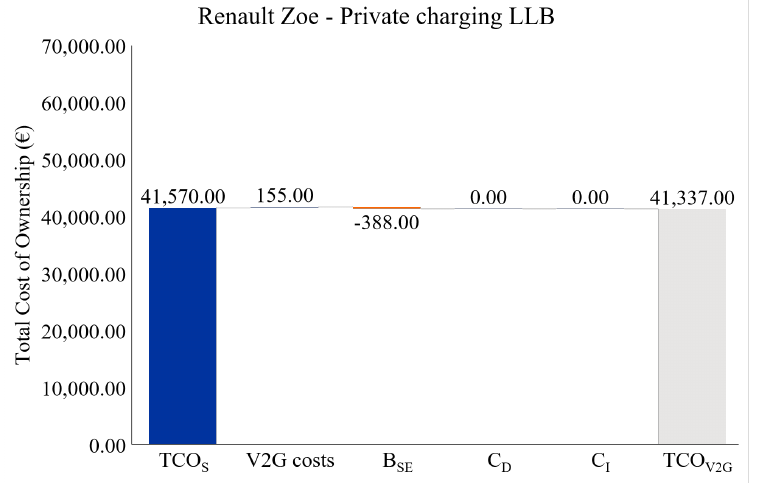
Figure A1. Standard and V2G TCO of a Renault Zoe in a private charging case providing LLB ( TCO S = Standard TCO, B SE = benefit of saved electricity costs from the grid, C D = direct compensa- tion, C I = indirect compensation, TCO V 2 G = V2G TCO); source: own